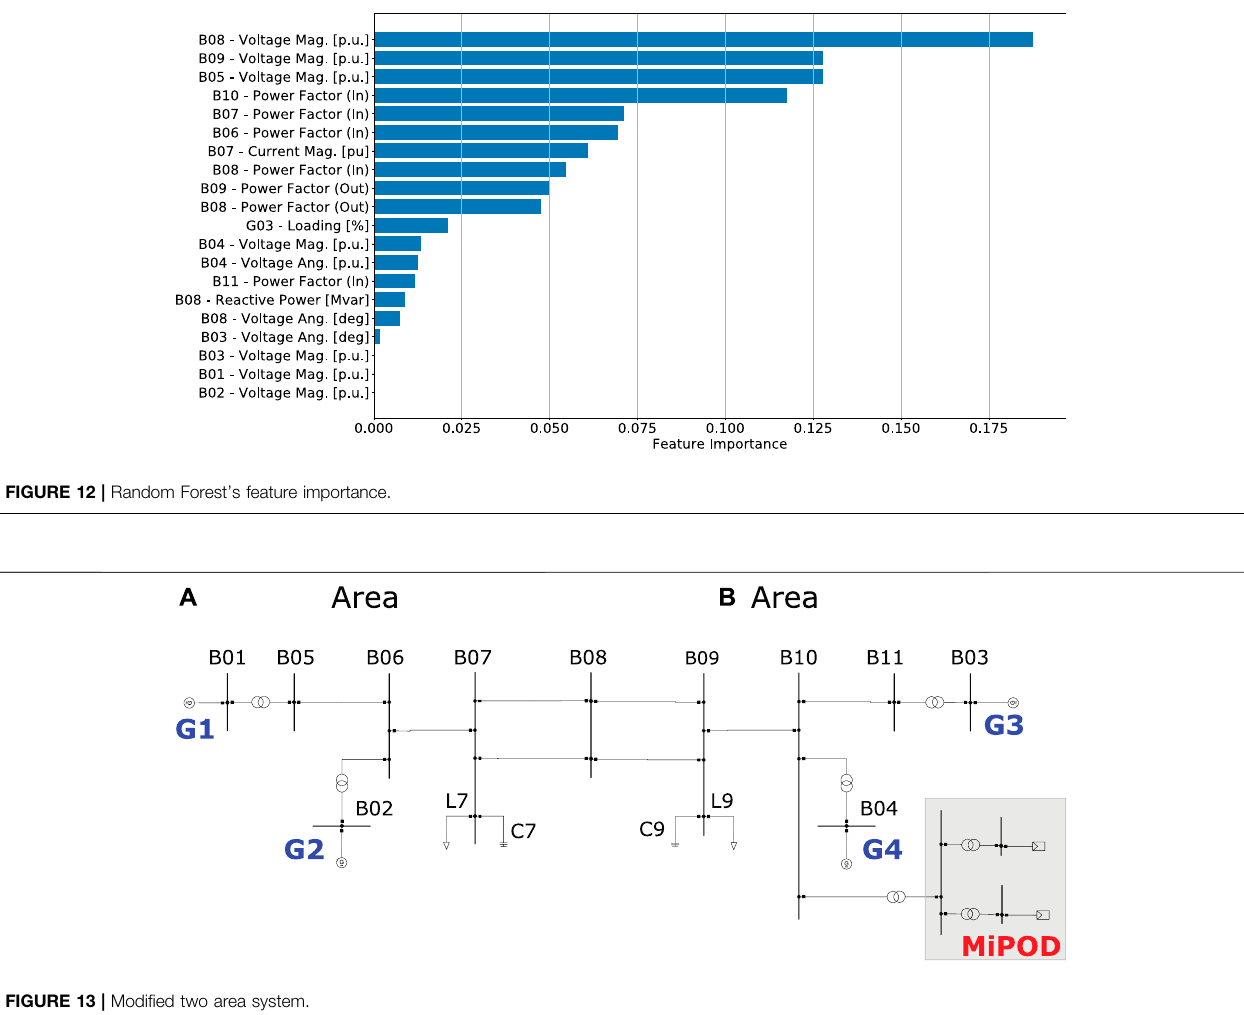
FIGURE 13 | Modi fi ed two area system.